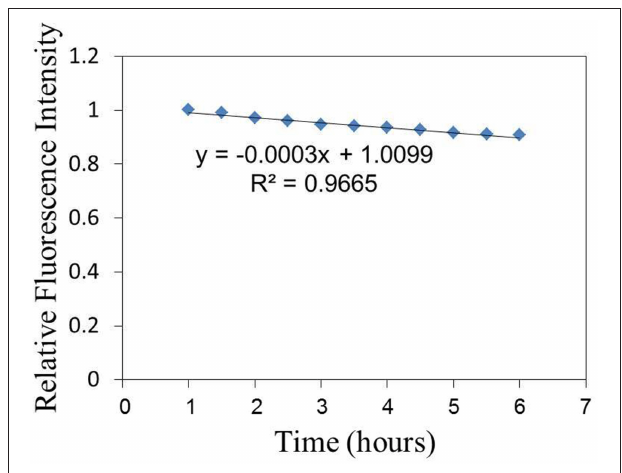
FIGURE 3 | The relative fluorescence intensity changes of FITC of the sensor adhered to substrate induced by the excitation